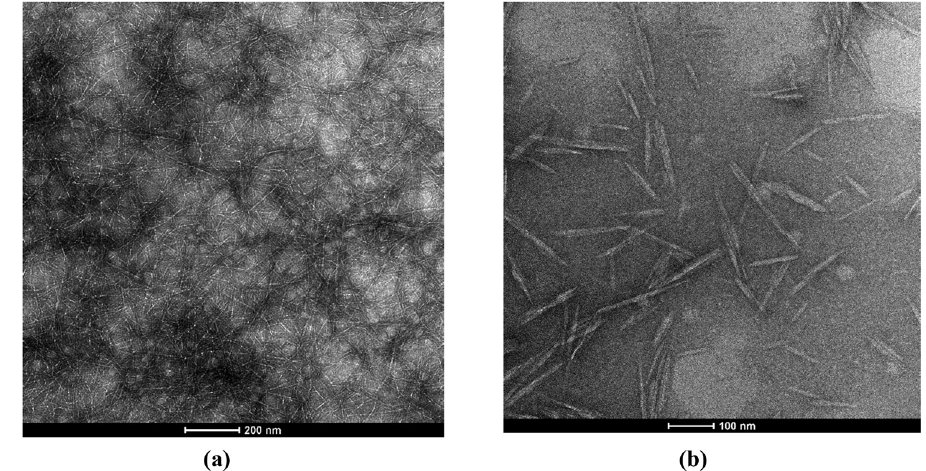
Figure 30: ( a ) TEMPO - oxidized CNFs and ( b ) CNCs prepared by acid